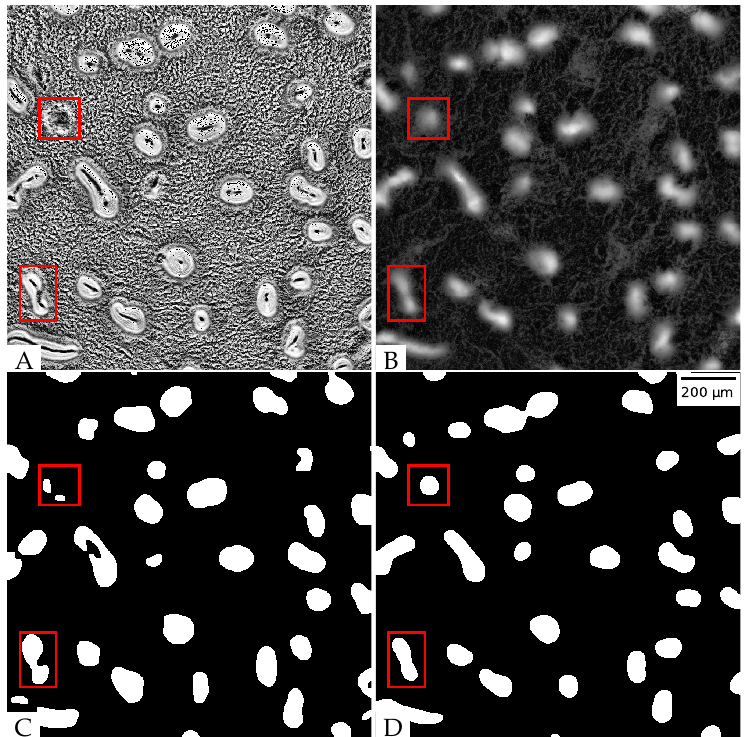
Figure 3. Aggregates extracted from different images at the 740th min: ( A ) Normalized phase- contrast image; ( B ) normalized tdTomato fluorescent image; ( C ) aggregates separated from the phase-contrast image; ( D ) aggregates separated from the fluorescent